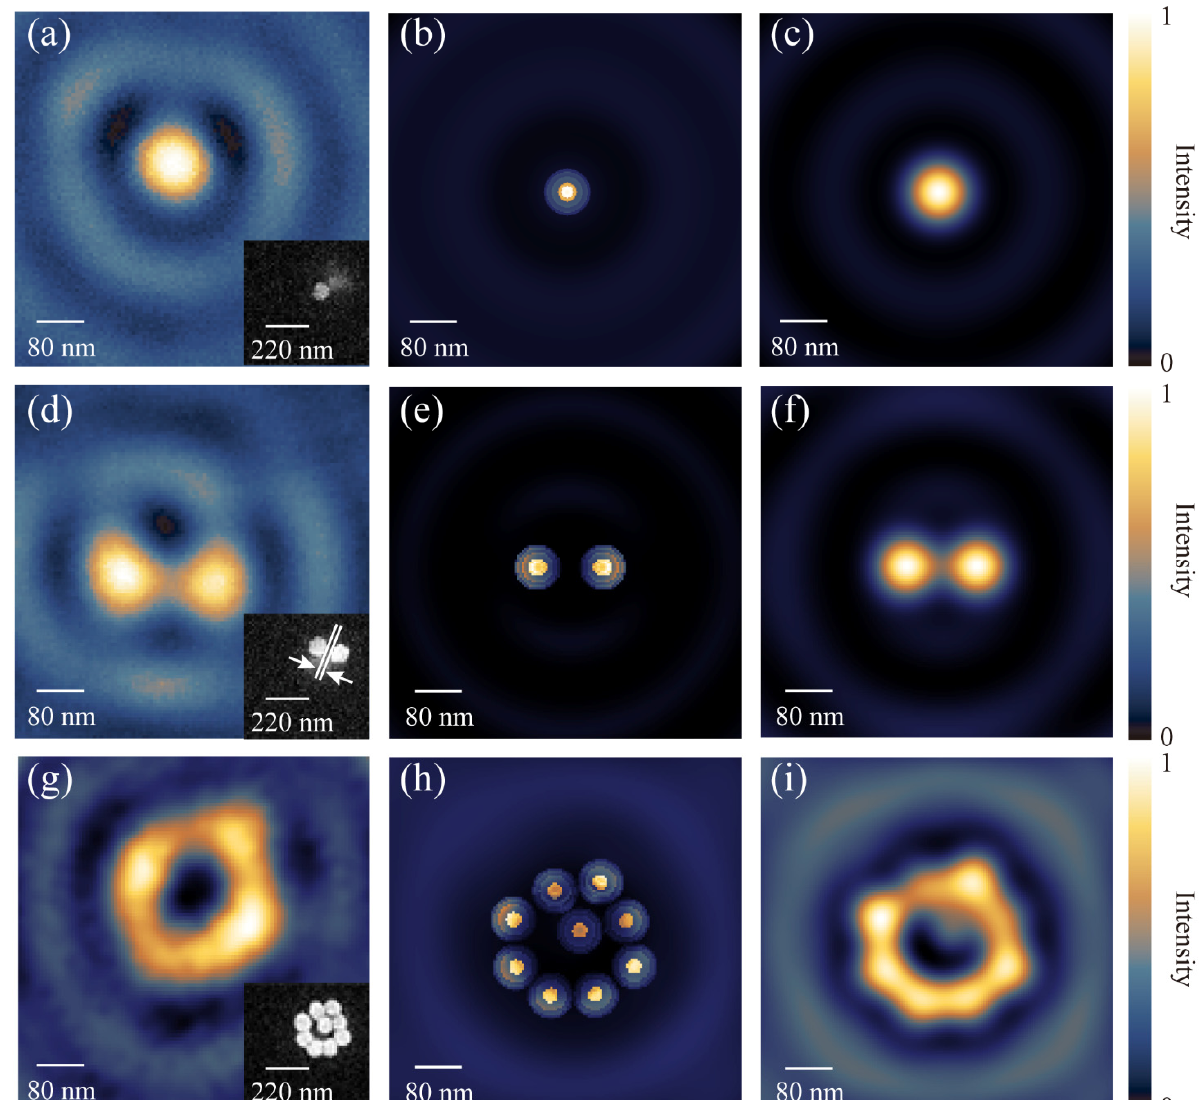
Figure 5. Fabrication of the template and process of capillary-assisted assembly of AuNPs. ( a ) Tem- plate fabrication: the designed PMMA template is defined by thermal probe writing. ( b ) Nanopar- ticle self-assembly: AuNPs accumulate on the pattern via the self-assembly process. ( c ) SEM image of assembled AuNPs on PMMA template, which shows the average lateral dimension of the assem- bled AuNPs is approximately 80 nm.